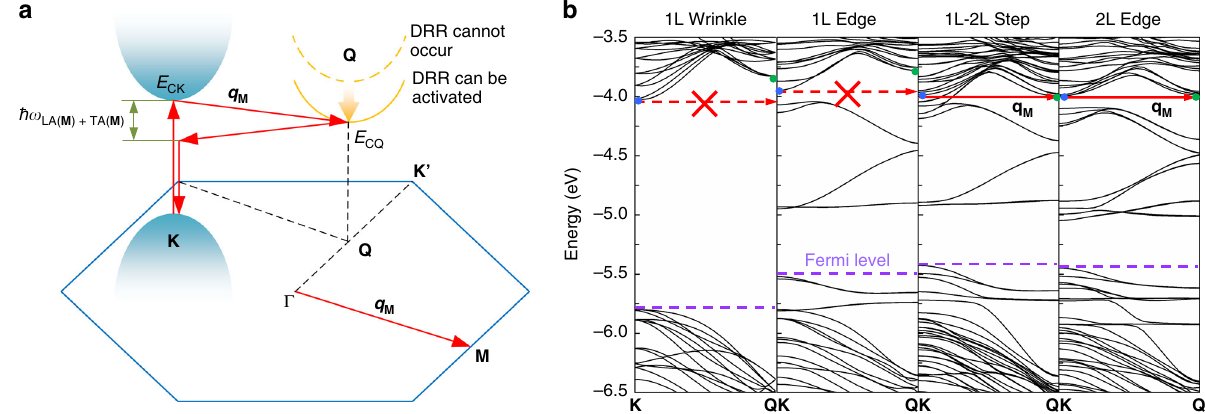
Fig. 2 DRRS in the defect. a Representation of DRRS process of the LA( M ) + TA( M ) mode. b Electronic band structures of monolayer wrinkle (monolayer nanoribbon with 0.4% strain (Supplementary Figs. 6 and 7), for more details see Supplementary Note 3), monolayer armchair nanoribbon (1 L edge), monolayer armchair nanoribbon on the monolayer basal plane (1 – 2 L step), and bilayer armchair nanoribbon (2 L edge). Blue and green dots are K and Q points of conduction bands, respectively. The solid horizontal red arrows indicate the DRRS can occur and the dash arrows cannot occur. Note that the width armchair nanoribbon employed here is ~2.4 nm. See Supplementary Note 3.3 for details about the electronic band structures of nanoribbon with different widths (1 – 3